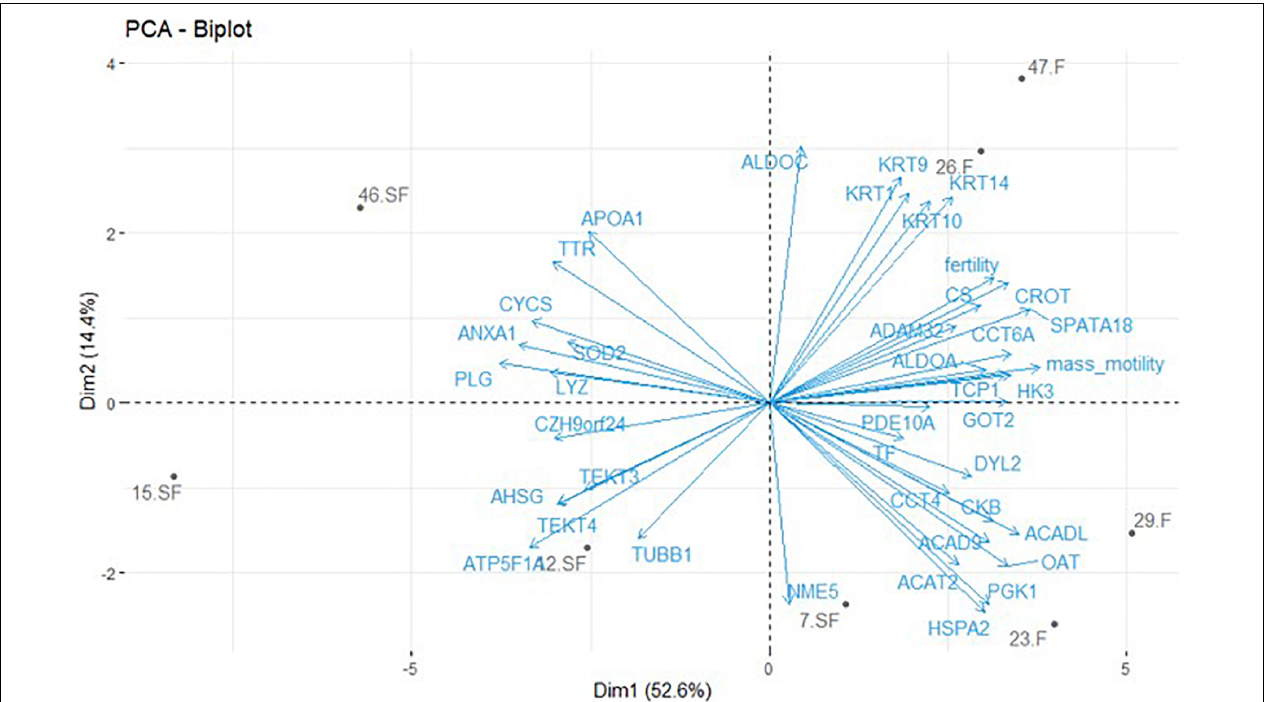
FIGURE 3 | Principal component analysis (PCA) of protein abundances obtained by GeLC-MS/MS with unique gene identification combined with fertility status and semen mass motility. Only DAP with a unique gene and an annotation (exclusion of LOC proteins) were included in this analysis. One significant DAP per cluster was retained and the mean signal calculated based on the three technical replicates obtained for each animal. Animals are revealed by their identification number and their fertility status (F = fertile; SF = subfertile). Animals are represented in gray and protein contribution as well as semen parameters in